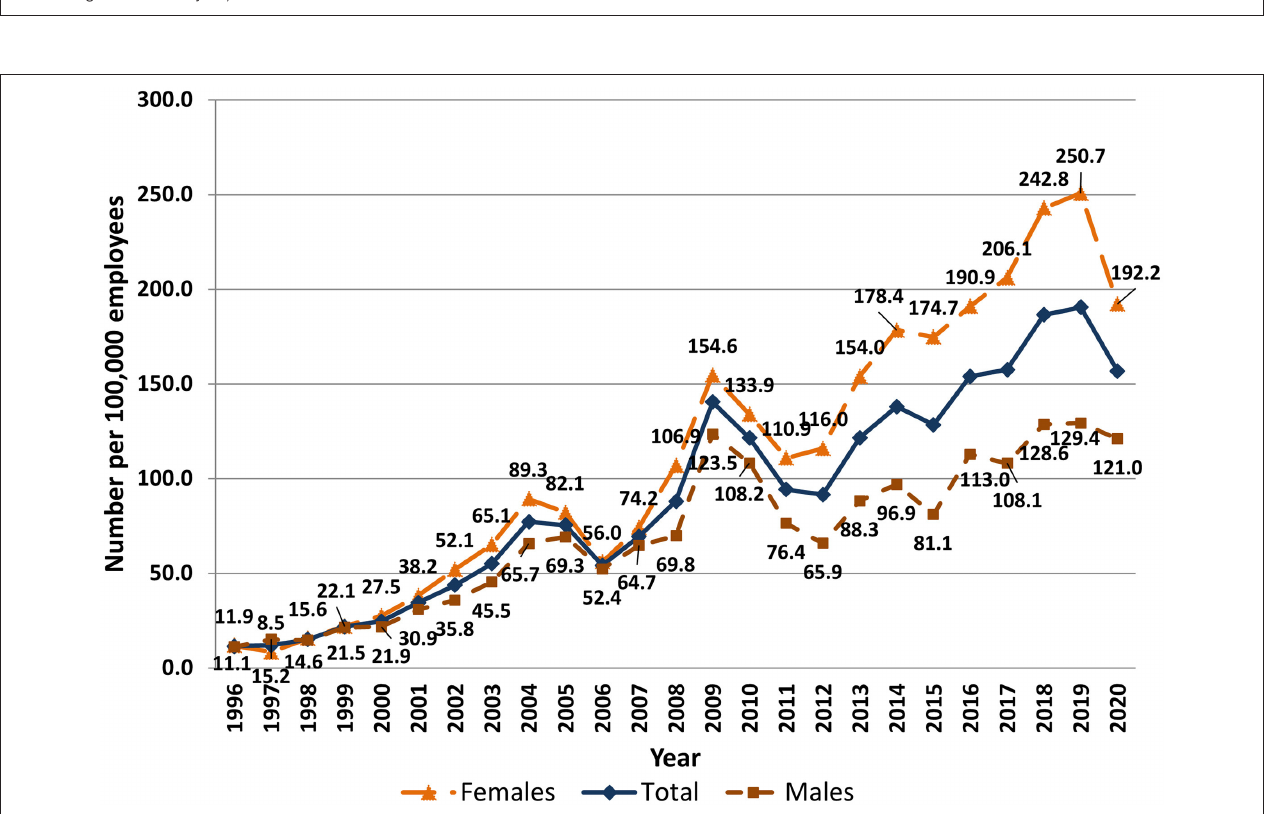
FIGURE 4 | Number of patients with first registered ODs in Latvia by sex and year, 1996–2020 (number of patients per 100,000 employees).